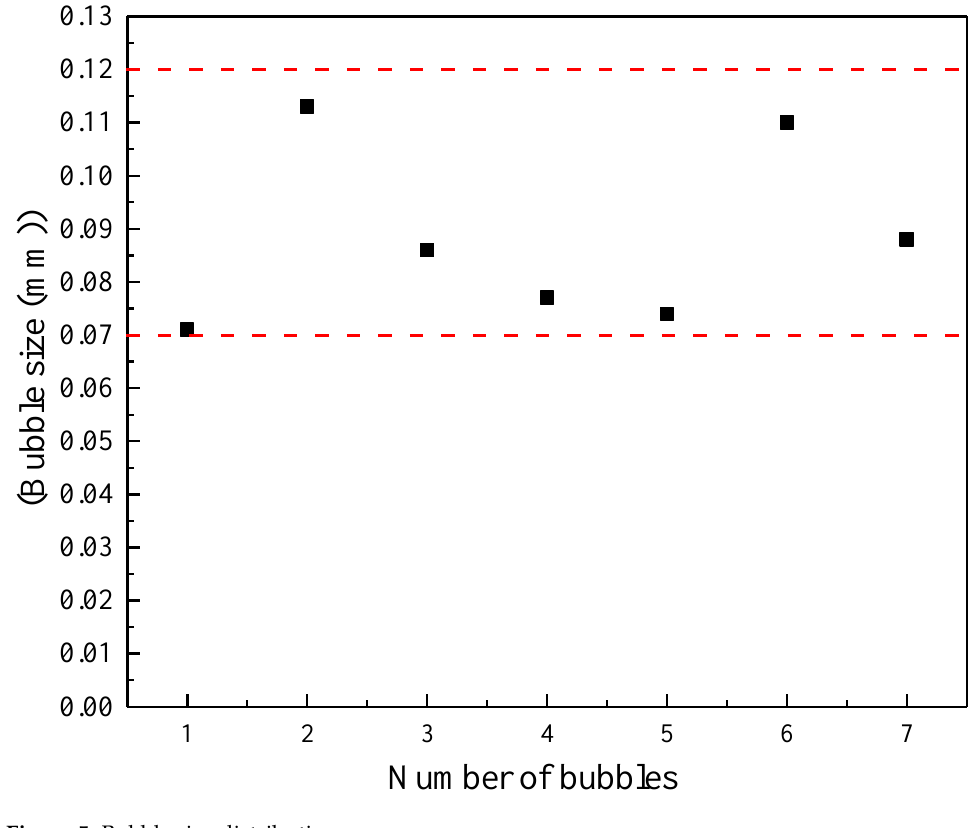
Figure 5. Bubble size distribution.